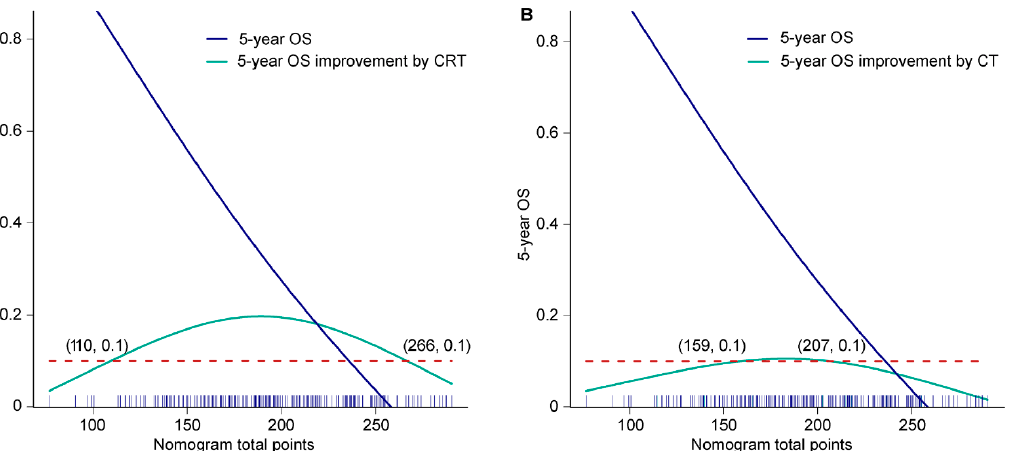
Figure 5. The 5-year OS improvement corresponding to the nomogram total point after ( A ) adjuvant chemoradiotherapy and ( B ) adjuvant chemotherapy. Blue solid line, 5-year OS rate corresponding